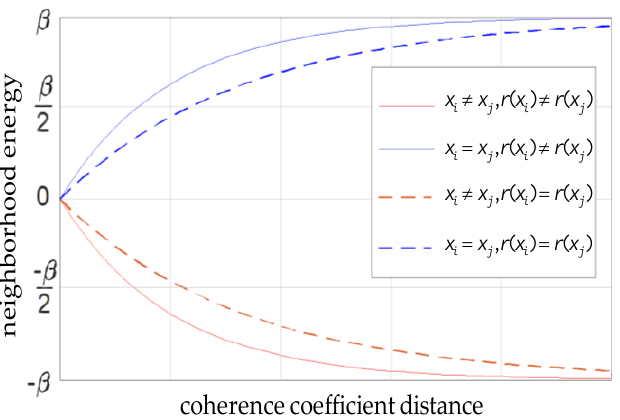
Figure 1. Curve of the neighborhood energy changing with the coherence coefficient distance and residue information.